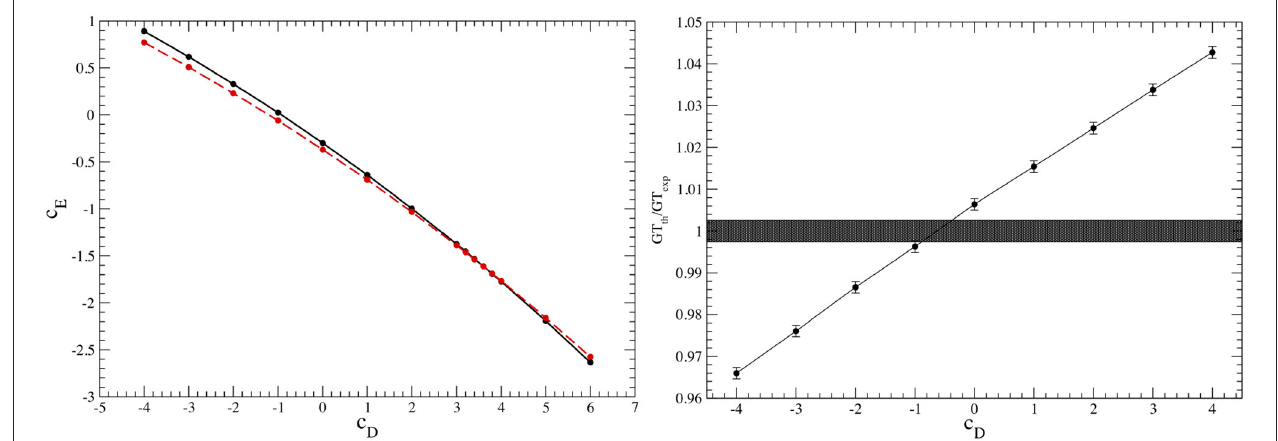
FIGURE 4 | (Left) The c D - c E trajectories obtained by fitting the experimental trinucleon binding energies (solid line) and nd doublet scattering length (dashed line) (the intercept of these two lines gives the c D and c E values that reproduce these two observables simultaneously). Figure taken from Piarulli et al. [93] under the Creative Commons CCBY license. (Right) The calculated ratio GT th /GT exp as function of c D (solid line; each point on his line reproduces the trinucleon binding energies). Figure taken from Baroni et al. [ 96] under the Creative Commons CCBY license.